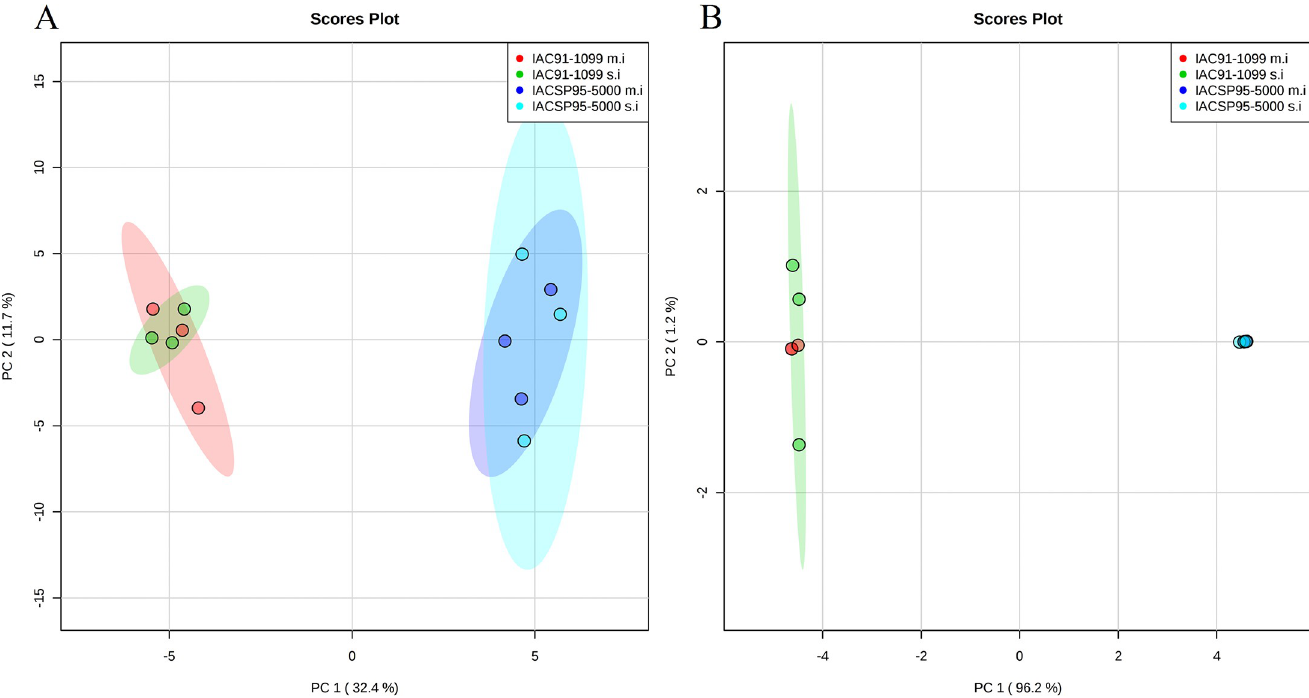
Fig 1. Principal coordinate analysis (PCoA) for A: methylation-susceptible loci (MSL) and B: nonmethylated loci (NML), representing epigenetic and genetic differences among groups, respectively.